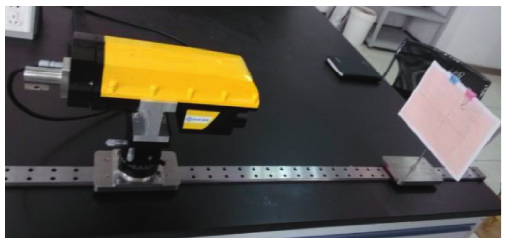
Figure 5: The angle parameter calibration platform of the inner structure.